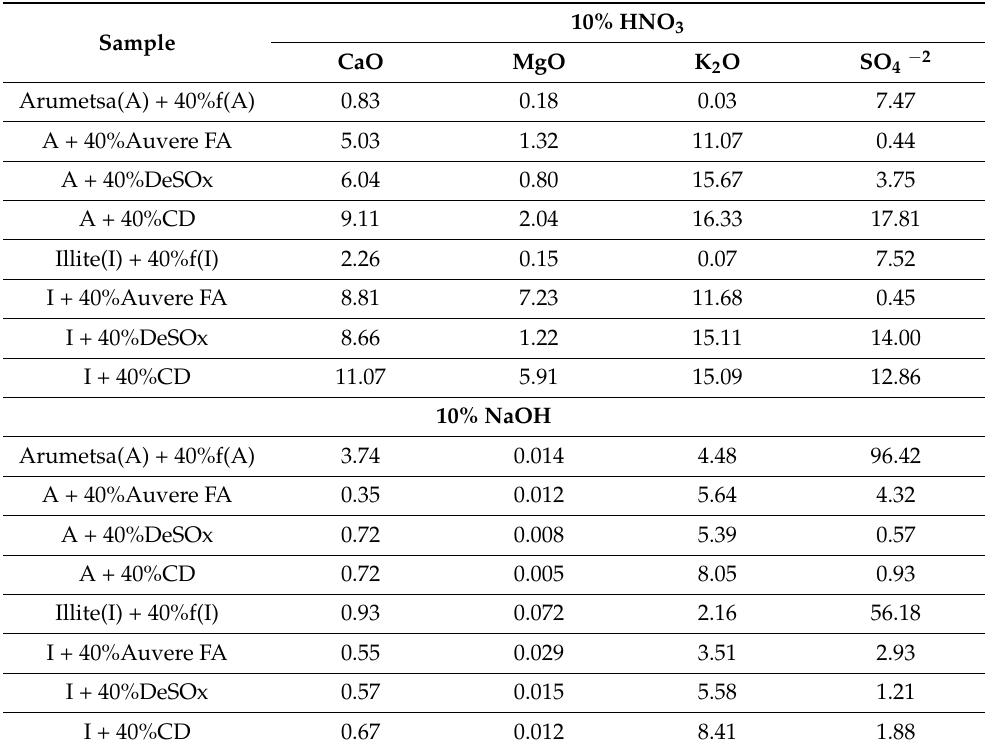
Table 4. Relative leachability of CaO, MgO, K 2 O and SO 4 − 2 (%) from thermally treated samples (1 h at 1050 ◦ C) in 10% water solution of HNO 3 and